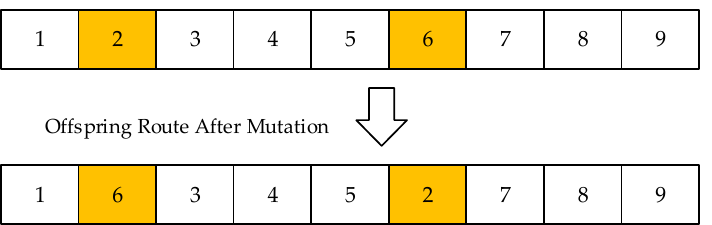
Figure 9. Swap mutation on the offspring route.